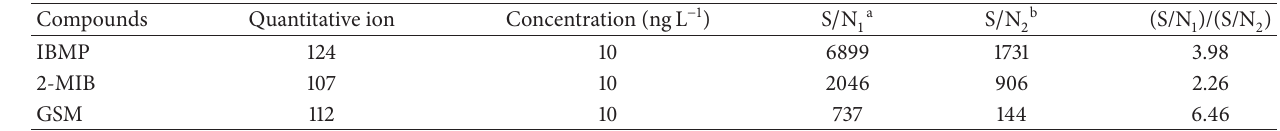
Figure 3: The determination of analytes in SIM mode. (a) Not using segments for the determination of analytes in SIM mode. (b) The MS scan function (SIM mode) for the determination of analytes. Table 6: The comparison of the signal to noise ratio (S/N) by two methods.